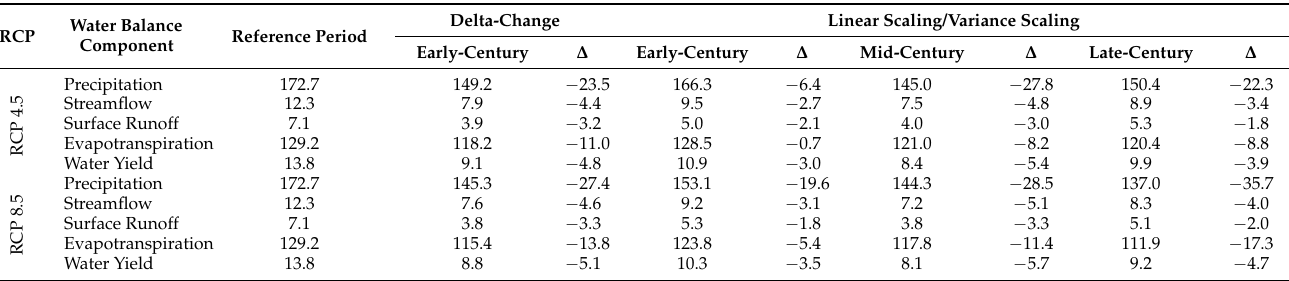
Table 7. Simulated changes ( ∆ ) to mean annual water balance component of AZB under different climate change scenarios in mm (Note: Mean precipitation values represent the basin-wide average precipitation value simulated by SWAT model).